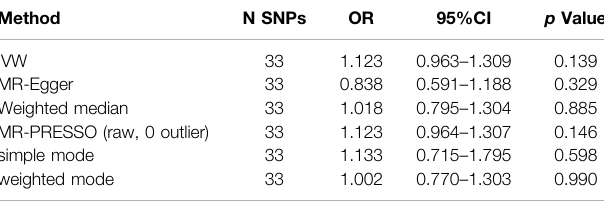
TABLE 2 | The causal association of CRP levels with ALS